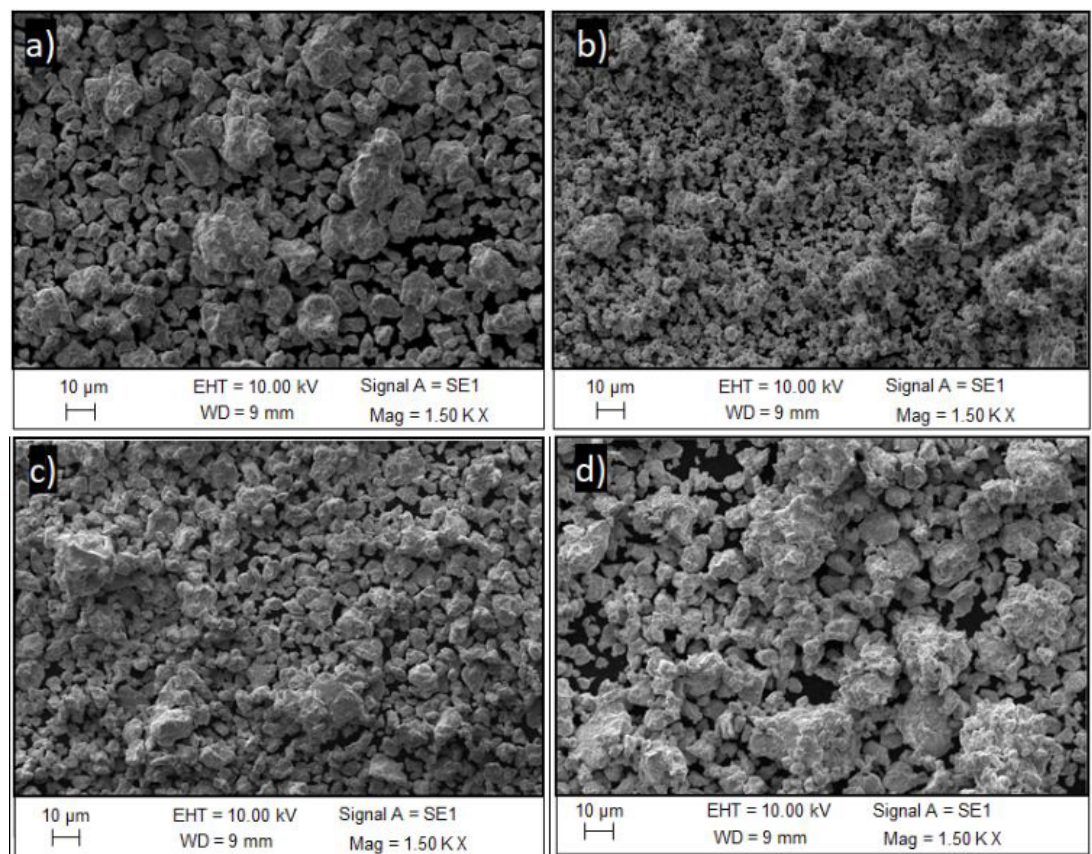
Figure 5. SEM/SE micrographs of alloys (a) Fe-15at.%Nb samples without PCA (reference), (b) Fe-15at.%Nb samples with methanol PCA, (c) Fe-15at.%Nb samples with hexane PCA, and (d) Fe-15at.%Nb samples Fe-15at.%Nb samples with stearic acid PCA at 80 hours